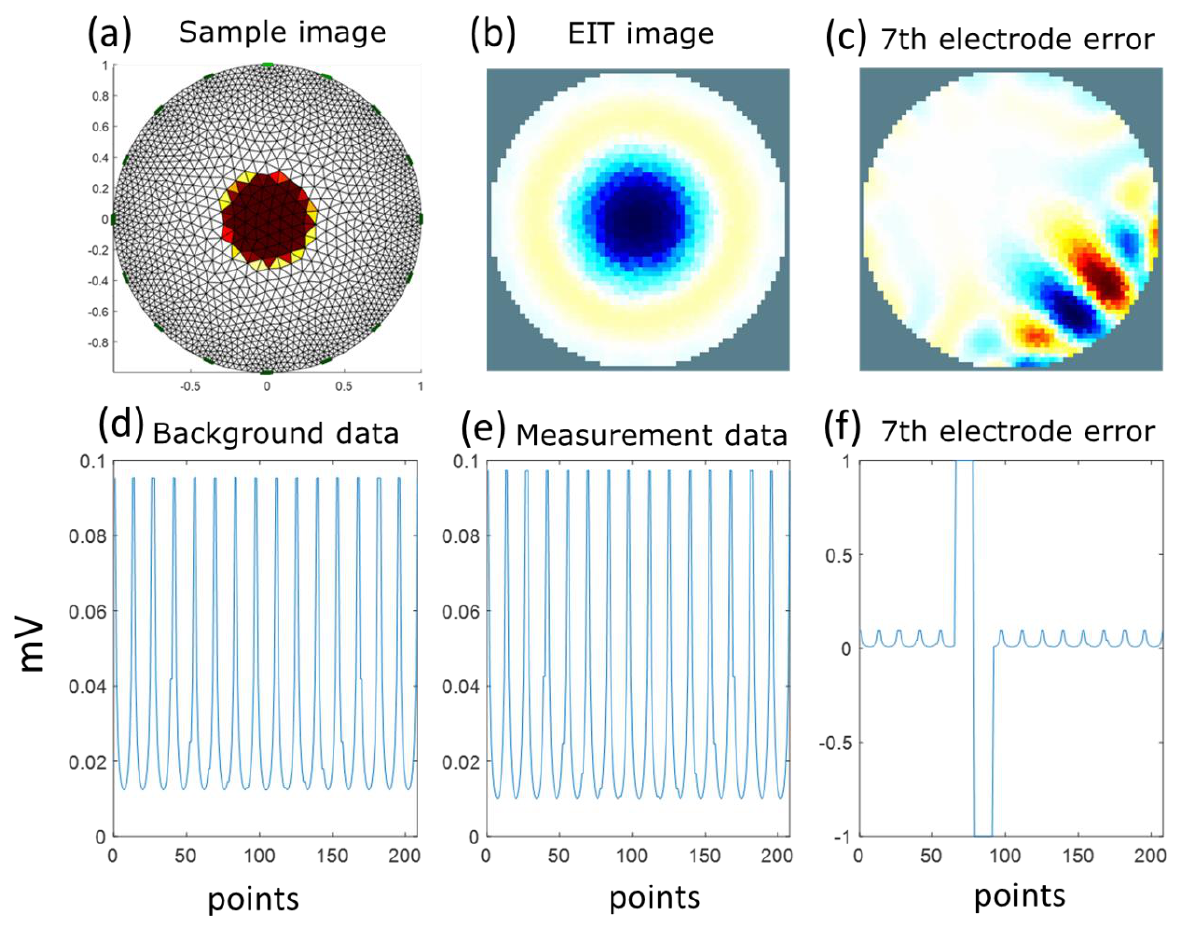
Figure 1. Simulated sample and reconstructed images. ( a ) Sample image. ( b ) EIT image. ( c ) EIT image with the seventh electrode detached. ( d ) Background data. ( e ) Measurement data with 16 well-contacted electrodes. ( f ) Measurement data with the seventh electrode detached.